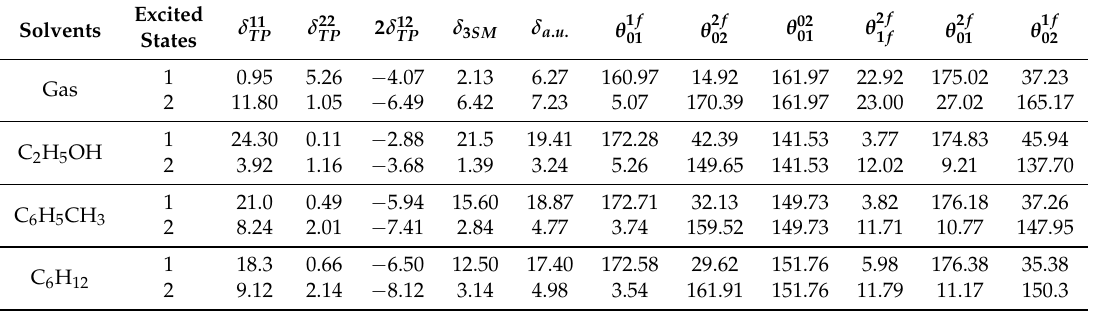
Table 5. Three-state model results for TP transition probability, for the first two excited states of D-luciferin in gas and solvent phases. All the δ values are in 10 4 a.u., and angles are in degree.